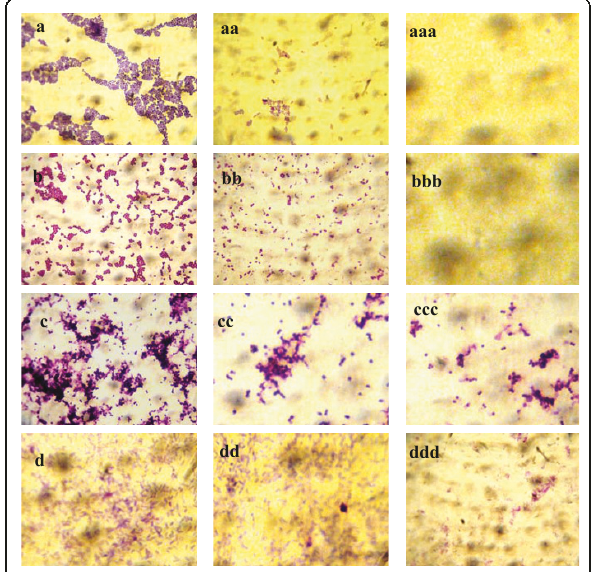
Figure 1 Microscopic visualization of the effect of thymoquinone on four biofilm positives strains cultured on glass slides covers . Prevention of biofilm formation effect of TQ was as followed: For S. aureus ATCC 25923 a, non treated slides; aa, cells supplemented with TQ MIC; aaa, cells supplemented with TQ 2 × MIC. For S. epidermidis CIP 106510, b, positive control (non treated slides); bb, cells supplemented with TQ MIC; bbb, cells supplemented with TQ 2 × MIC.For E. faecalis ATCC 29212, c, non treated slides; cc, cells supplemented with TQ MIC; ccc, cells supplemented with TQ 2 × MIC. For P. aeruginosa ATCC 27853, d, non treated slides; dd, cells supplemented with TQ MIC; ddd, cells supplemented with TQ 2 ×